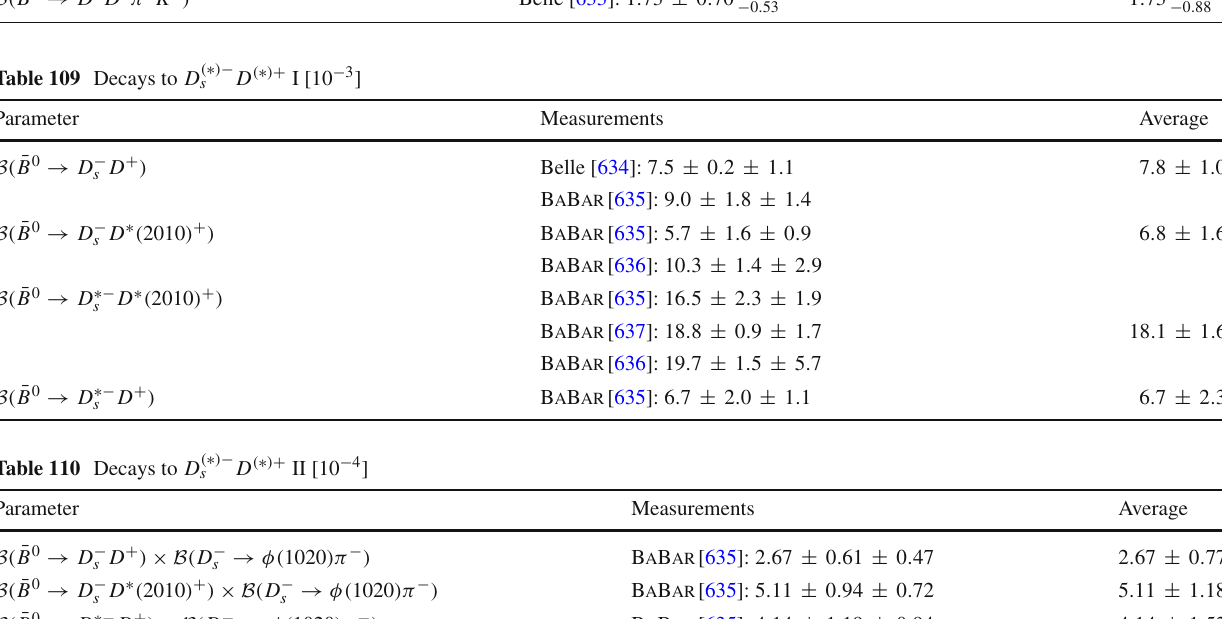
Table 109 Decays to D